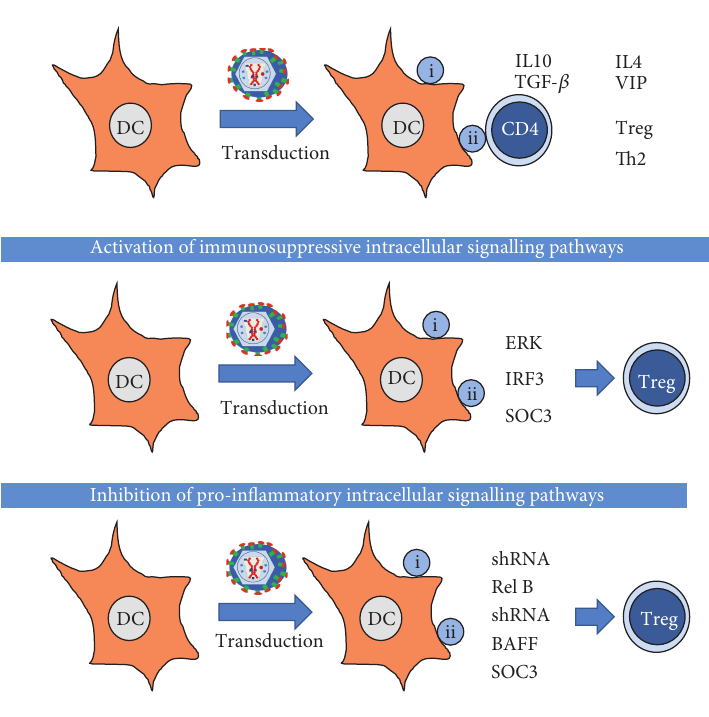
F 5: �ain strategies for the induction of immunological tolerance by genetic modi�cation of DCs using retroviral/lentiviral vectors. In this scheme, the most utilised strategies for the induction of immunological tolerance using gene modi�cation of DCs are shown. On top, using lentiviral or retroviral vectors, the expression of immunosuppressive cytokines in DCs can induce the differentiation of antigen-speci�c Tregs, or in some cases, 2 cells. In the middle, lentivectors can be used to express constitutive activators or immunosuppressive intracellular signalling pathways leading to the differentiation of suppressive T cells. On the bottom, lentiviral vectors can either deliver short hairpin RNAs targeted towards proin�ammatory pathways such as NF- �, proin�ammatory receptors such as �AFF, or inhibitors of cytokine signalling such as SOC3. All these strategies also lead to the development of suppressive T cells. Not shown in any of these schemes, all strategies lead to differentiation of tolerogenic DCs which will either prevent the expansion of cytotoxic CD8 T cells, or induce their 𝜅𝜅